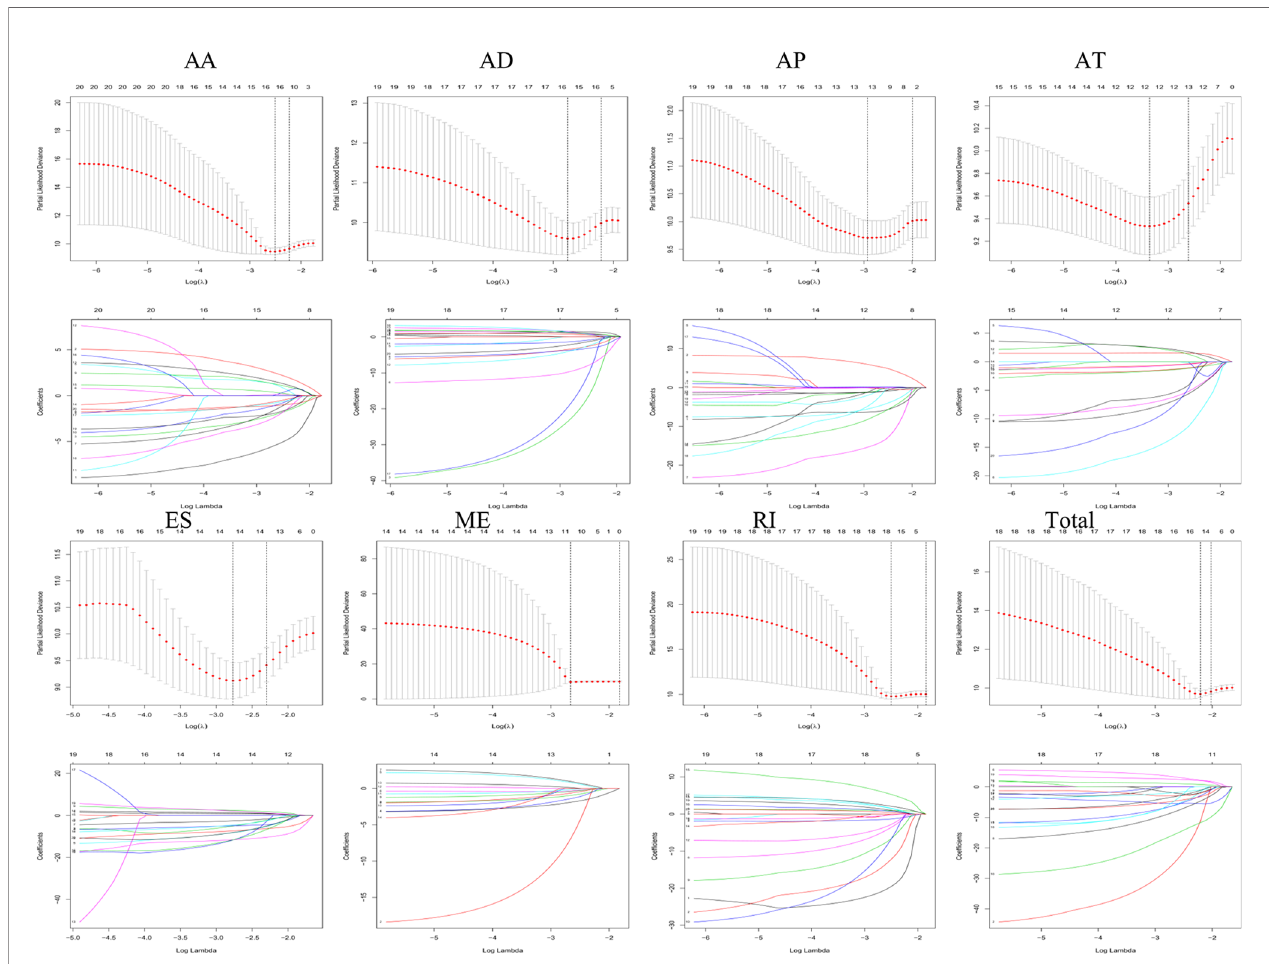
FIGURE 3 | The selection of survival-associated AS events by Lasso regression analysis that avoided over fi tting and excluded co-expression.